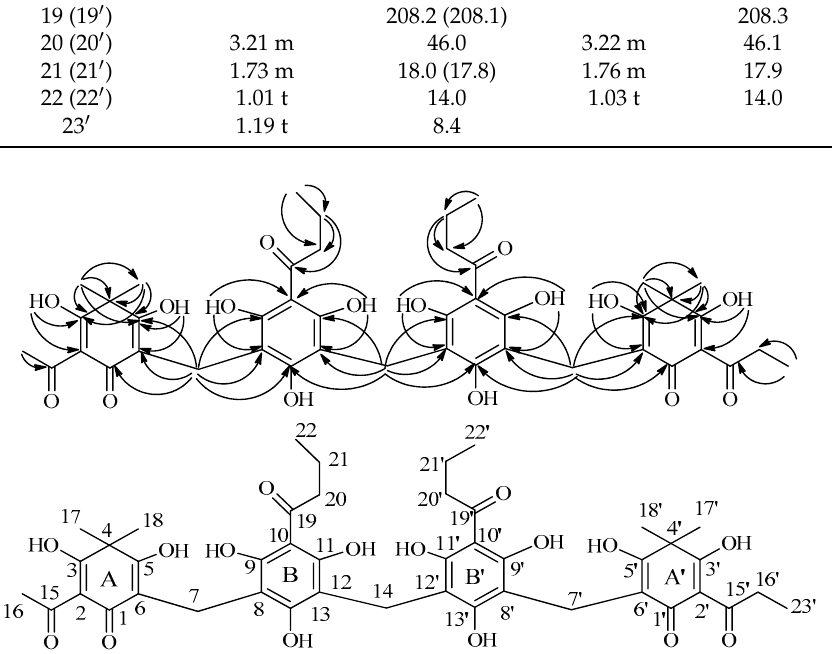
Figure 4. Structure of compound 7 and its HMBC correlations.